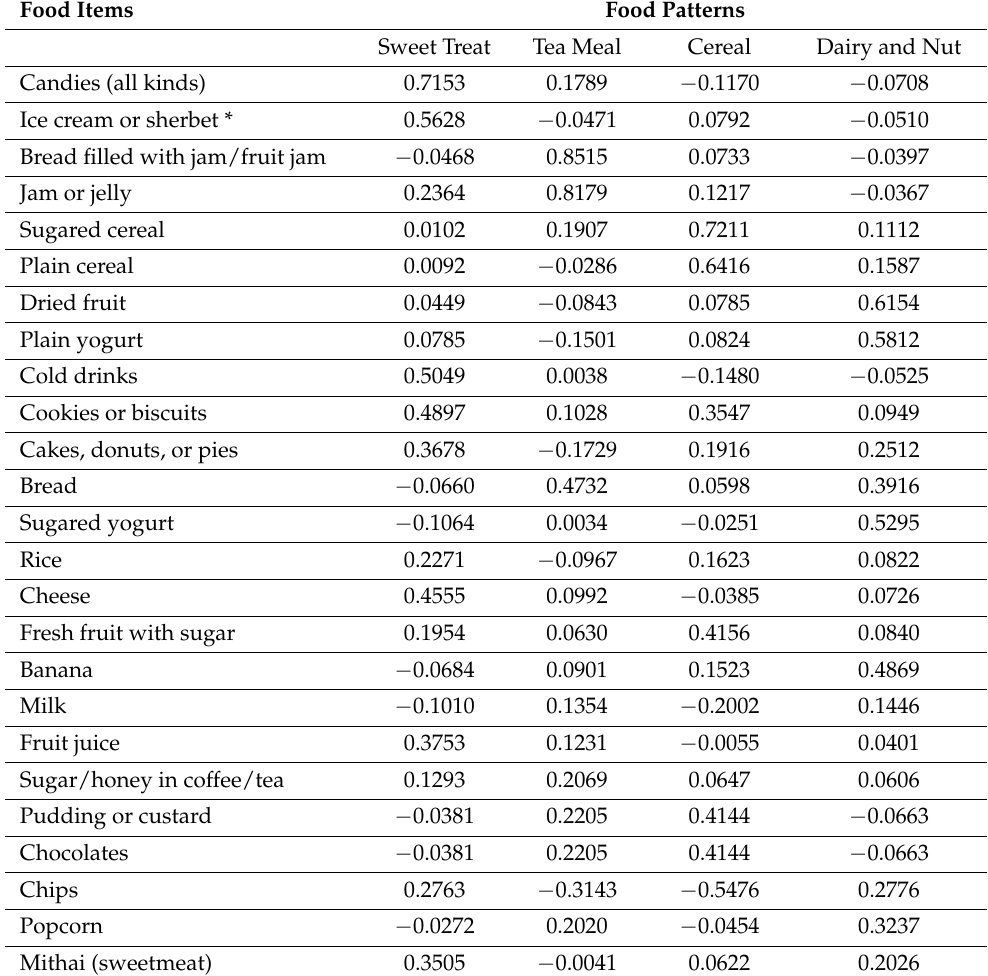
Table 2. Factor-loading matrix for four dietary factors ( n = 1730).